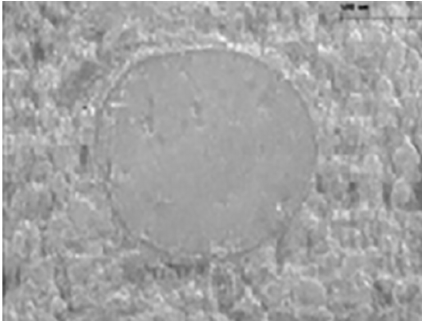
FIGURE 2 - SEM Image of Cross-sections of tablet using TEC as